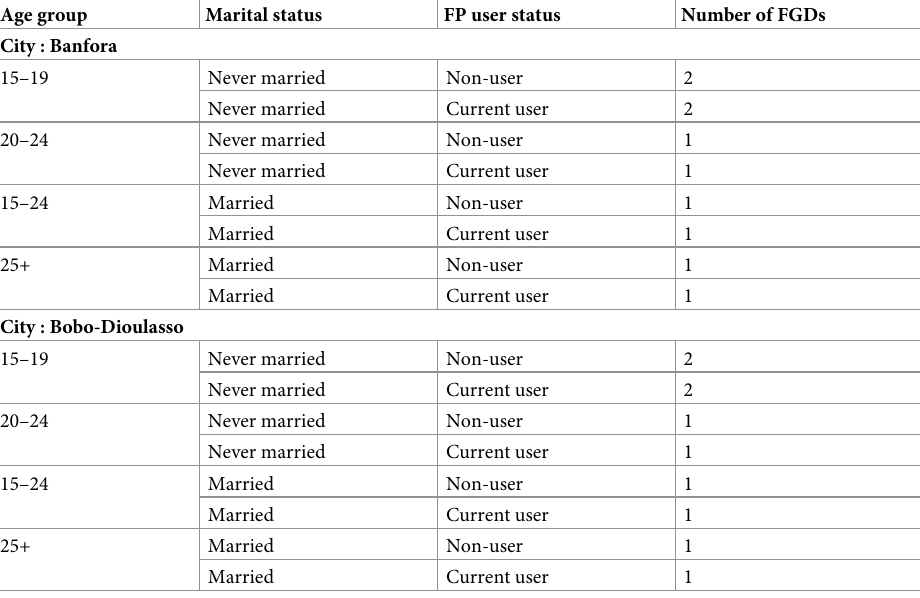
Table 1. Number of FGDs by type of participant, Burkina Faso,